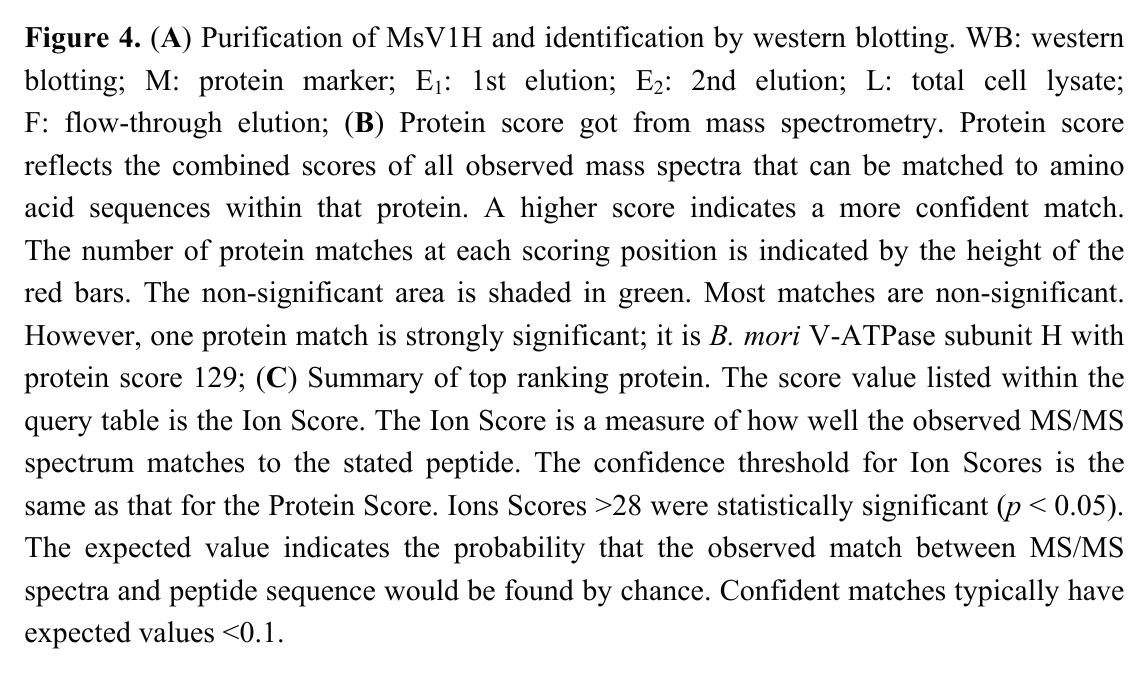
: 1st elution; E : 2nd elution; L: total cell 1 2